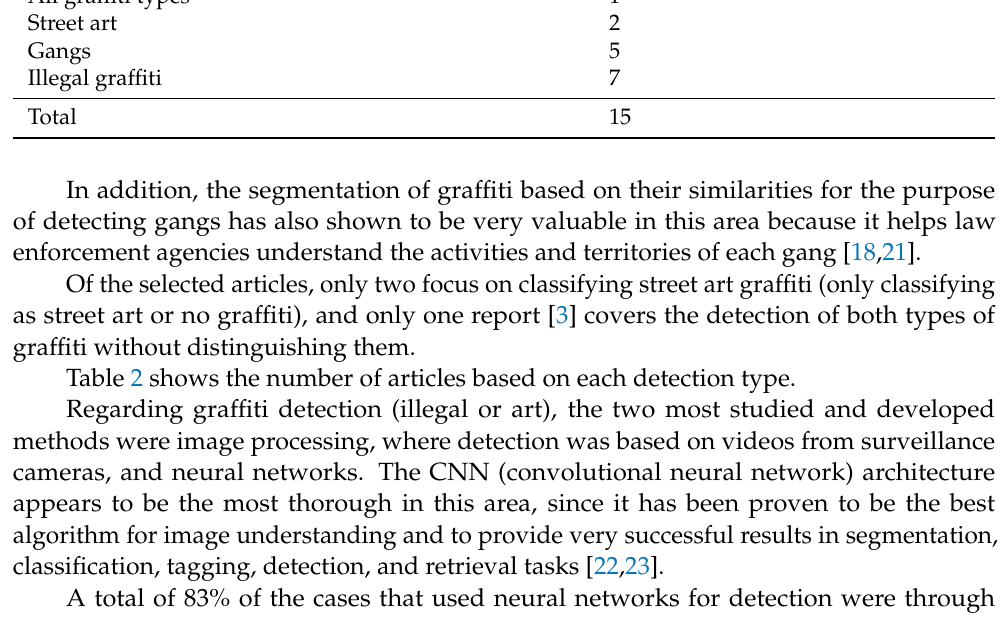
Table 2. Number of articles by type of detection. Type of Detection Number of Articles All graffiti